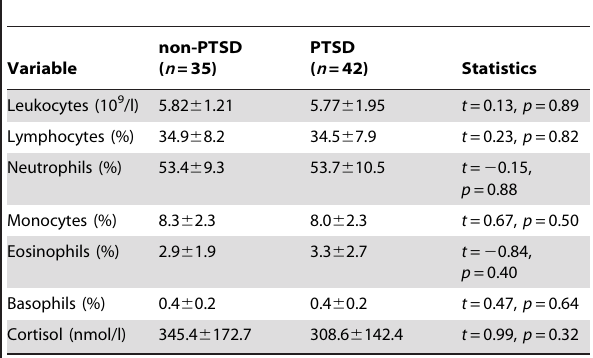
Table 2. Blood cell parameters and plasma cortisol concentration.